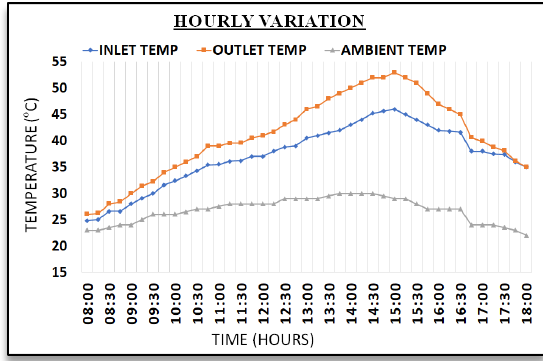
Figure 15. Temp vs Time values observed on a foggy day